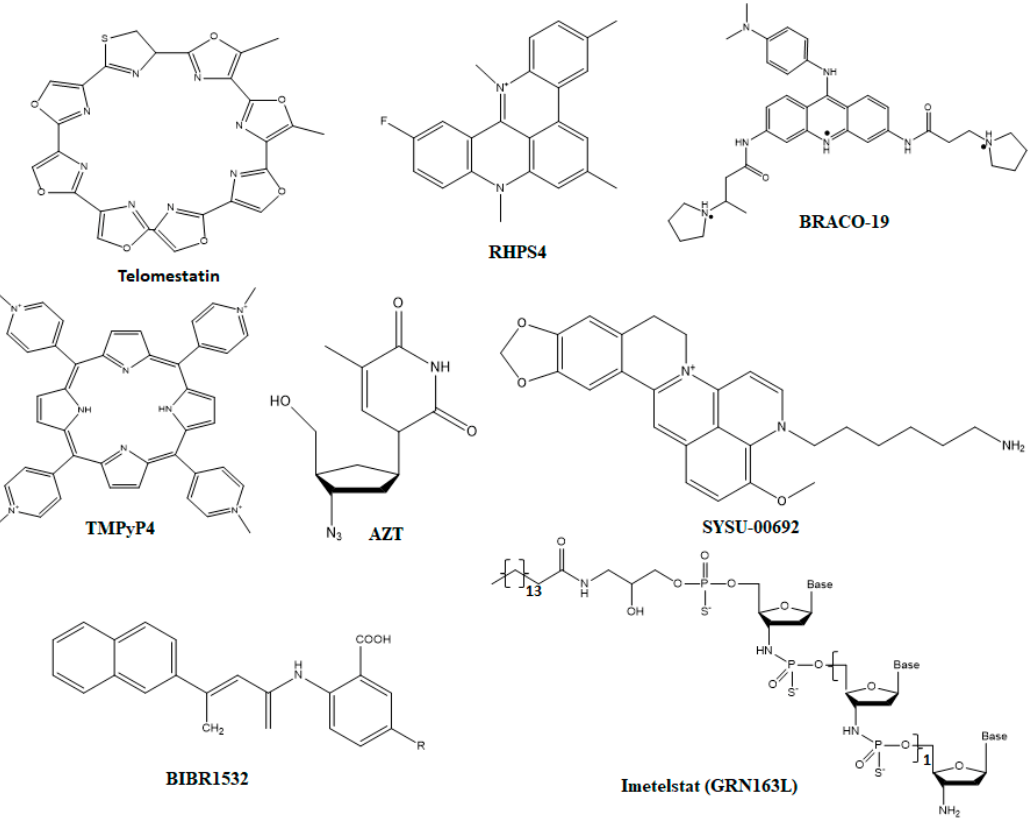
Figure 5. Structures of small molecule inhibitors that target different molecular interactions responsible for the telomere integrity. The chemical structures compounds depicted here have binding affinity against protection of telomeres 1 (POT1).